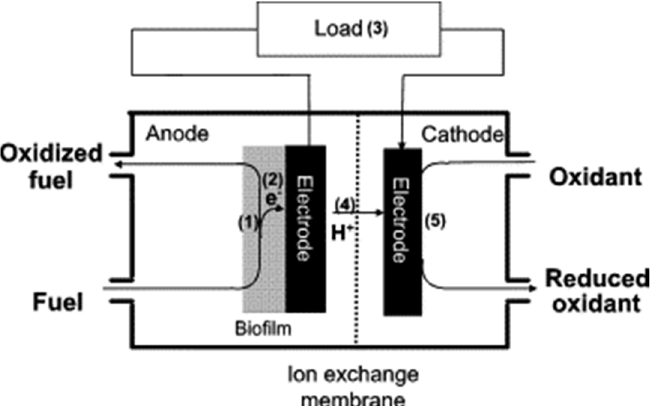
Figure 1. Schematic working of a microbial fuel cell and factors limiting the performance. (1) Anodic catalytic activity, (2) microorganism to electrode electron transfer, (3) load resistance, (4) proton transfer through the membrane to the cathode, and (5) dissolved oxygen concentration and reduction rate at the cathode. Reproduced with permission from Ref. [39] .